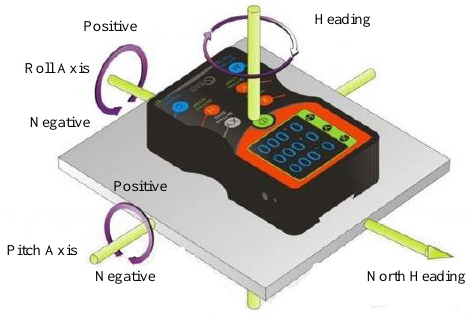
Figure 3. 3D model of an orientation sensor .